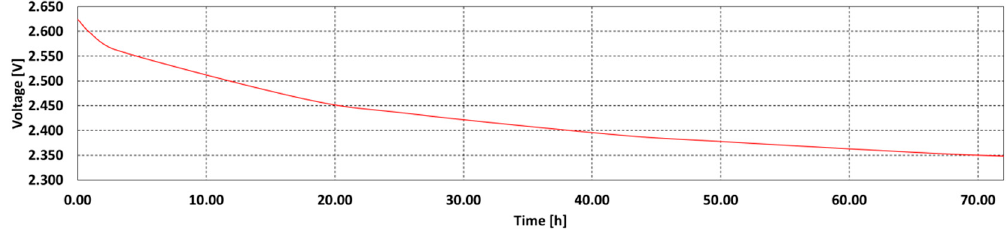
Figure 6. Experimental results of the redistribution of electrical loads and leakage current assay on an SC cell (BCAP3000F 2.7 V) during 72 h after a period of charge.